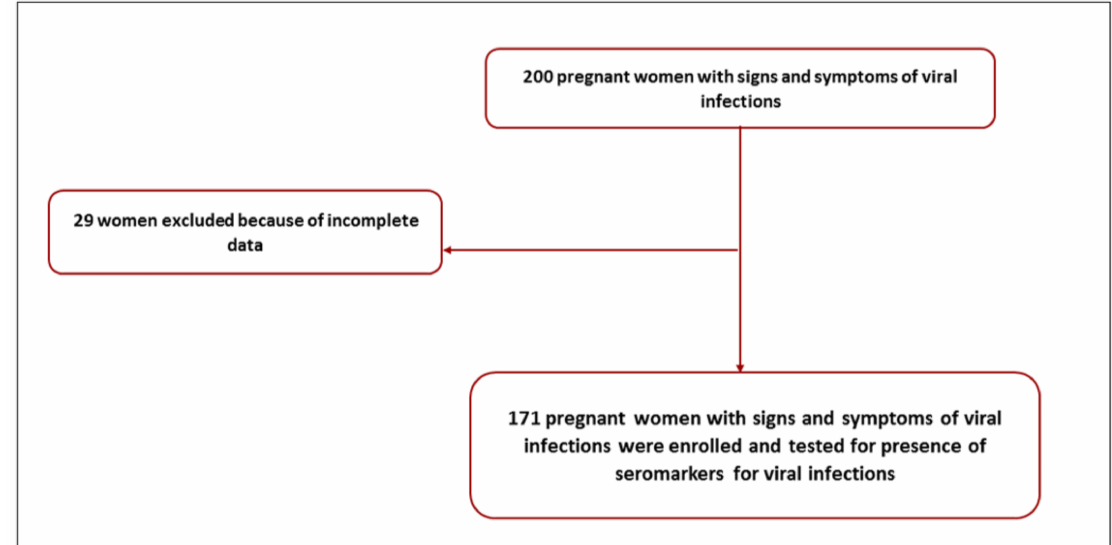
Figure 1. Enrollment flow chart.